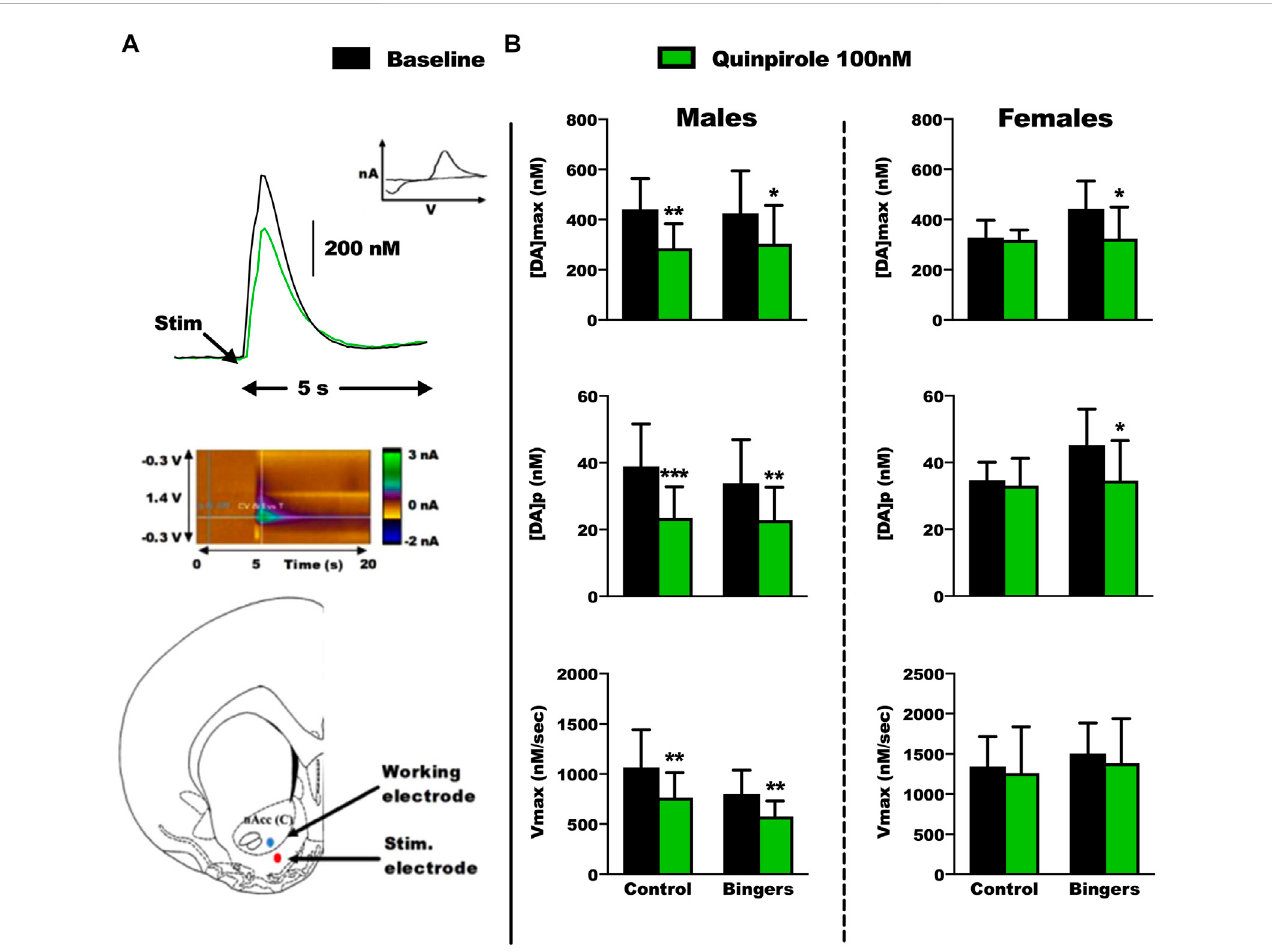
FIGURE 5 Ex-vivo FSCV results inmale and female rats. Control: n = 6 males and n = 6 females, Bingers: n = 8males and n =7 females. (A) Top panel: Exampleof a FSCV trace from a control male rat, and characteristic voltamogramm of dopamine. Middle panel: Example of color plot from a control male rat during the FSCV recordings. Bottom panel: Electrode placements for the FSCV recordings in the core of the NAc. (B) Top panel: results for [DA] max in male and female rats. Results are expressed as mean ± SEM of the maximum extracellular [DA], in nM. Middle panel: results for [DA] p in male and female rats. Results are expressed as mean ± SEM of the [DA] per pulse of stimulation, in nM. Bottom panel: results for V max in male and female rats. Results are expressed as mean ± SEM of the dopamine transporter velocity, in nM/sec. * p < 0.05, ** p < 0.01, *** p < 0.001 vs. respective